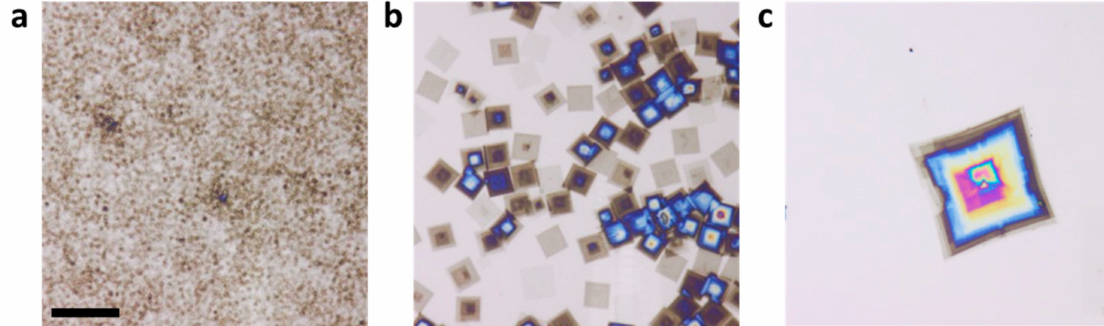
Figure 4. Influence of T SS on N and L . The optical micrographs show crystals obtained in a 10 mg/mL PS- b -PEO solution in toluene crystallized at T C = 13 ◦ C for 24 h after being 5 min at a self-seeding temperature ( a ) T SS = 35 ◦ C; ( b ) T SS = 40 ◦ C, and ( c ) T SS = 45 ◦ C. The scale bar represents 15 µ m.